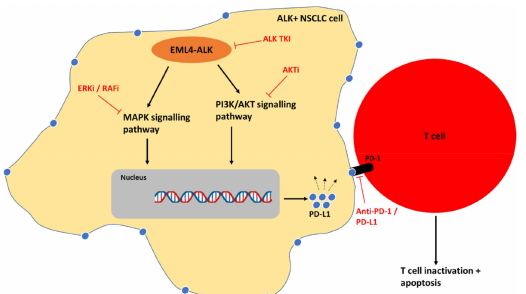
Figure 6. Combined EML4-ALK inhibition with PD-1/PD-L1-directed immunotherapy.